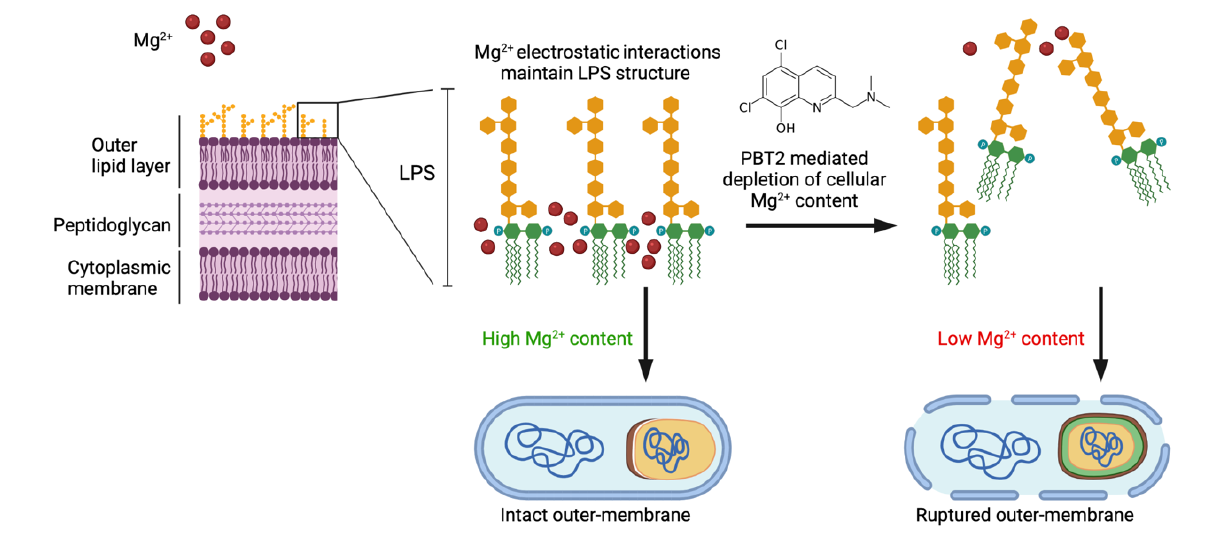
FIGURE 1: Proposed mechanism of PBT2 mediated membrane disruption and bacterial cell rupture. Magnesium binds to anionic phos- phate groups of the inner core via electrostatic interaction, enabling structural integrity of the outer leaflet. Disruptions in these important electrostatic cross-link interactions result in lipopolysaccharide (LPS) release and subsequent bacterial membrane rupture. We hypothesize PBT2 mediated dysregulation of bacterial cell metal homeostasis depletes A. baumannii of cellular magnesium content resulting in increased membrane permeability and associated membrane defects. Created with